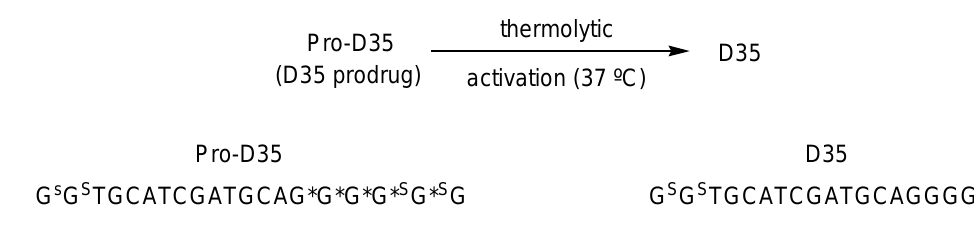
Figure 9. Thermolytic activation of Pro-D35.